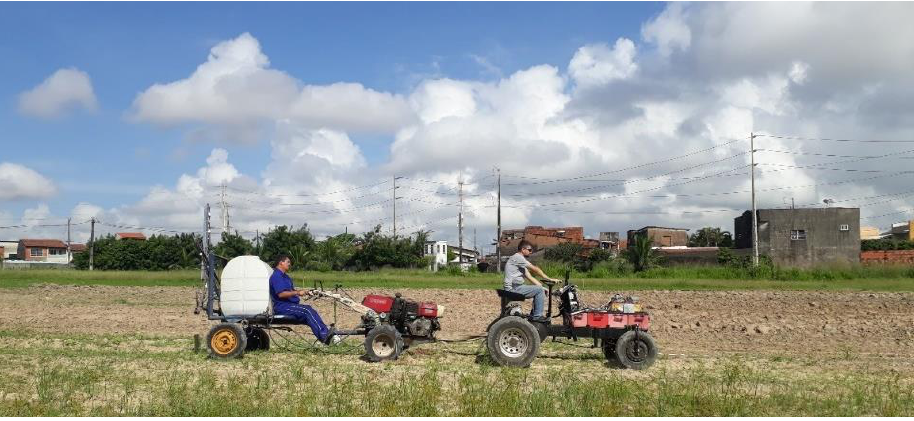
Figure 14. Electric tractor coupled to an agricultural sprayer and a 10.3-kW ICE